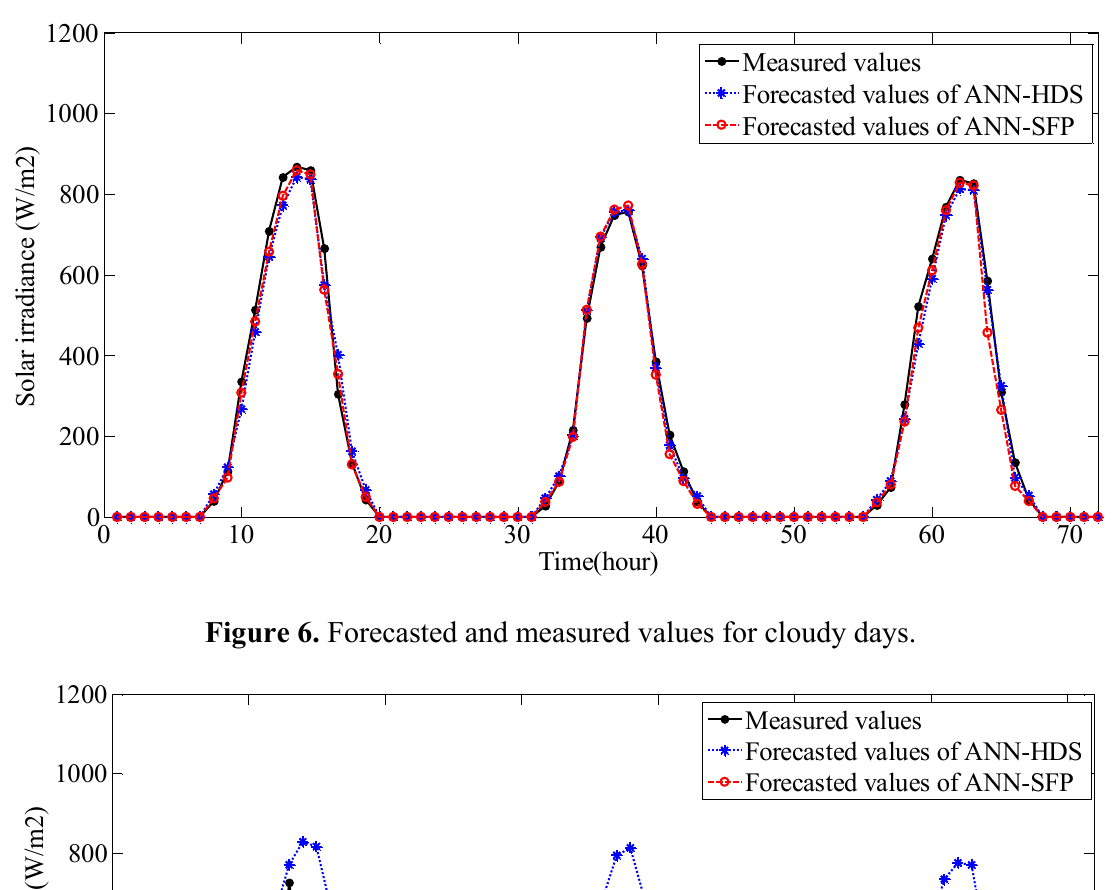
Figure 5. Forecasted and measured values for sunny days.